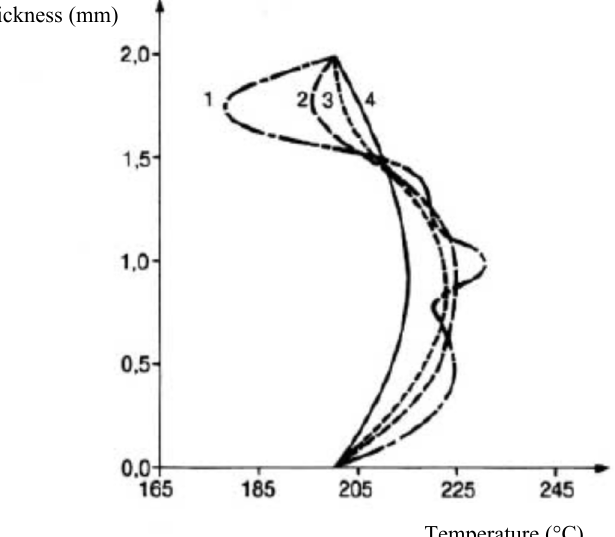
Figure 17. Variations of the temperature profile along the flow (the positions 1 to 4 are shown in Figure 16) (Reprinted from Ref. [15]).